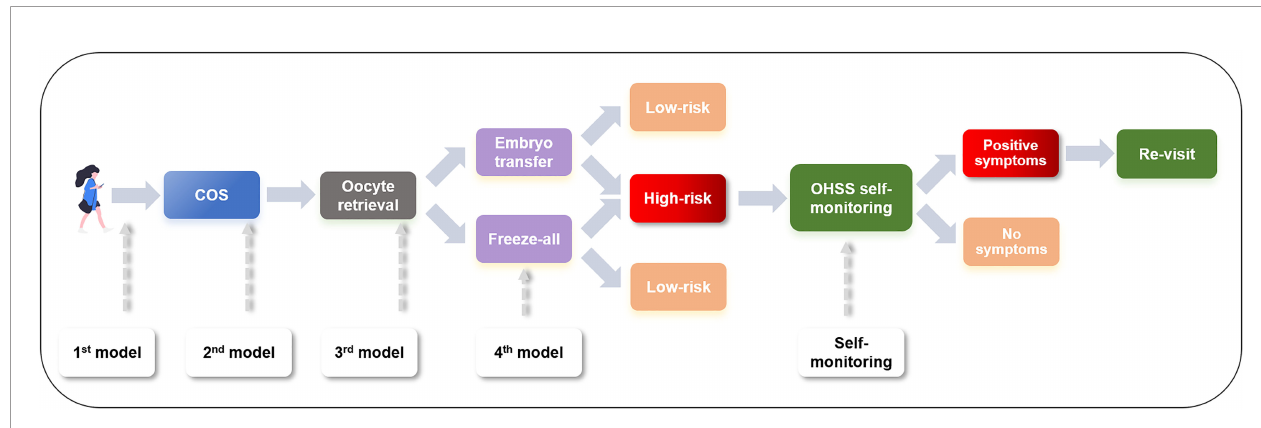
FIGURE 5 | Work fl ow of management of an OHSS patient. OHSS, ovarian hyper-stimulation syndrome; COS, controlled ovarian